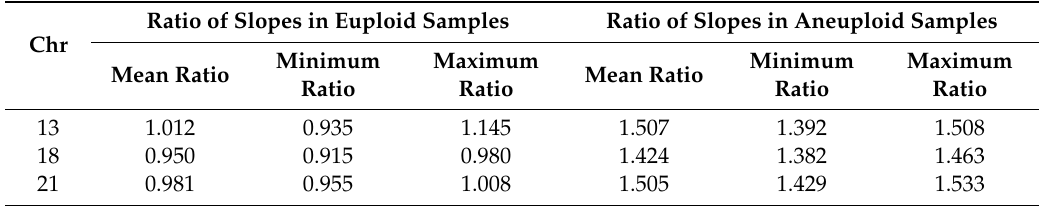
Table 1. Results obtained for duplex reactions using FAM and VIC-labeled probe assays. Ratio of Slopes in Euploid Samples Ratio of Slopes in Aneuploid Samples Chr Minimum Maximum Minimum Maximum Mean Ratio Mean Ratio Ratio Ratio Ratio